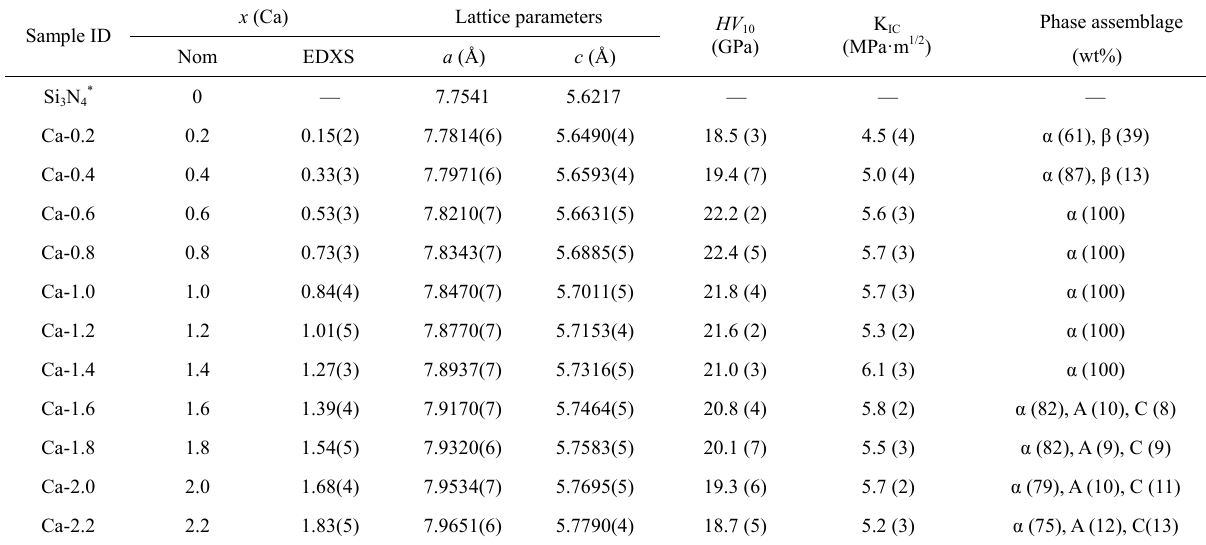
Fig. 5 (a) Regenerated schematic representation of α-plane in Ca-sialon system showing phase stability regime along the N’rich line at 1500 ℃ and (b) another representation where the orientation of the α-plane is one which is most commonly reported in the literature. Table 3 Lattice parameters, mechanical properties, and phase assemblage of calcium stabilized nitrogen rich sialons synthesized at 1500 ℃